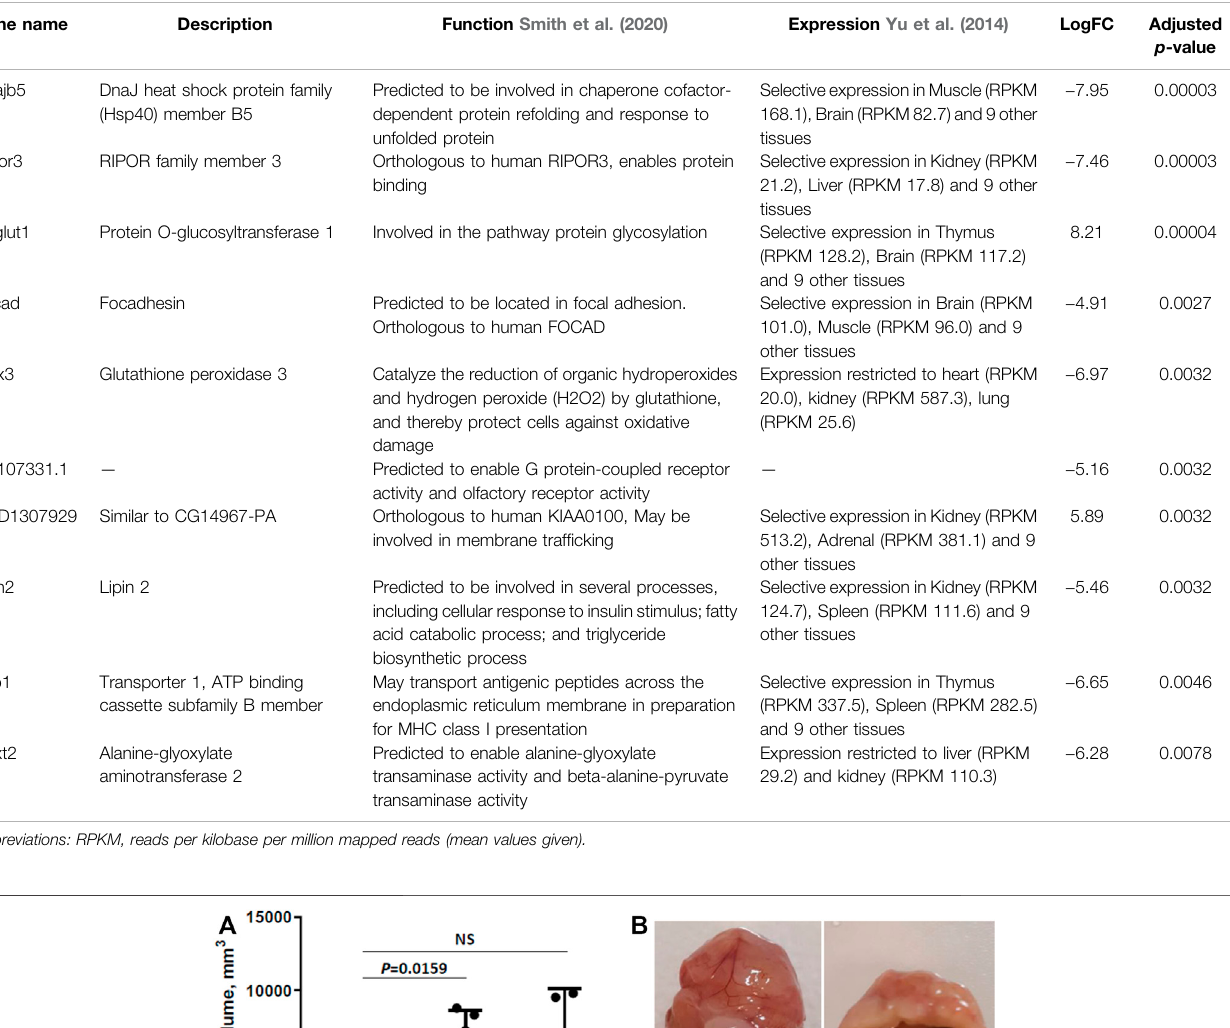
TABLE 2 | Top 10 differentially expressed genes in Pre-RUN vs . sedentary control EVs.